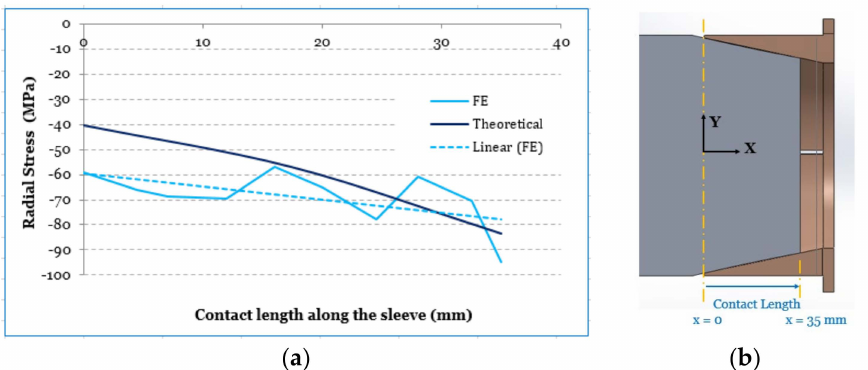
Figure 9. Sleeve radial stress along contact length. ( a ) Comparison of sleeve radial stress; ( b ) illustra- tion of contact